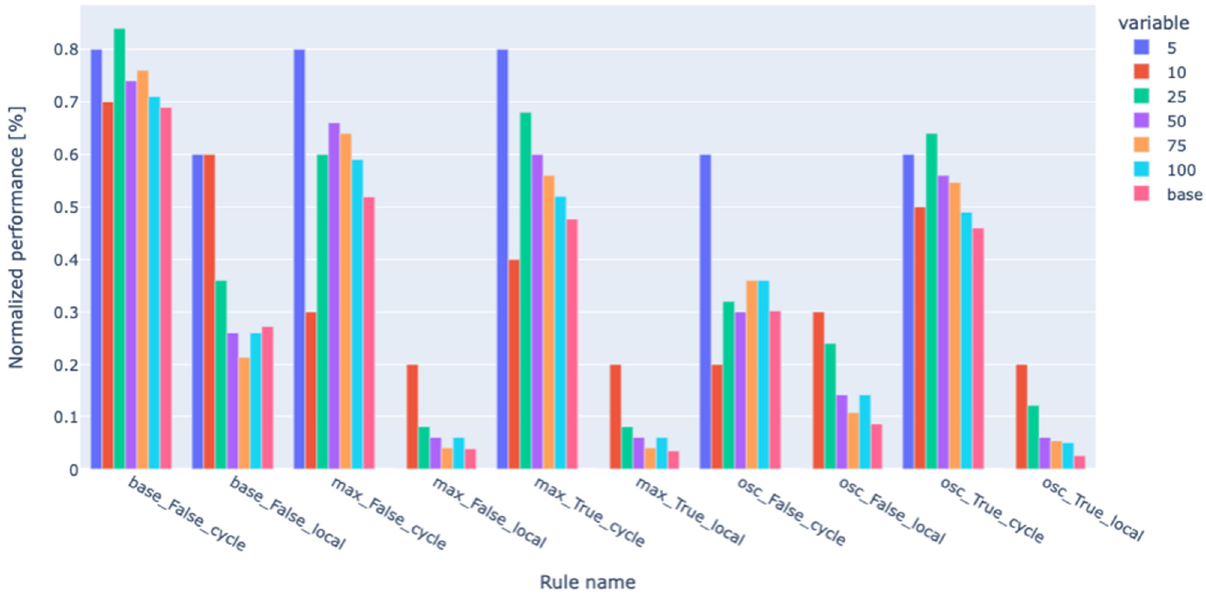
Figure 13. Impact of various clusters of the daily demands on the performance of sequencing and lot-sizing rules.